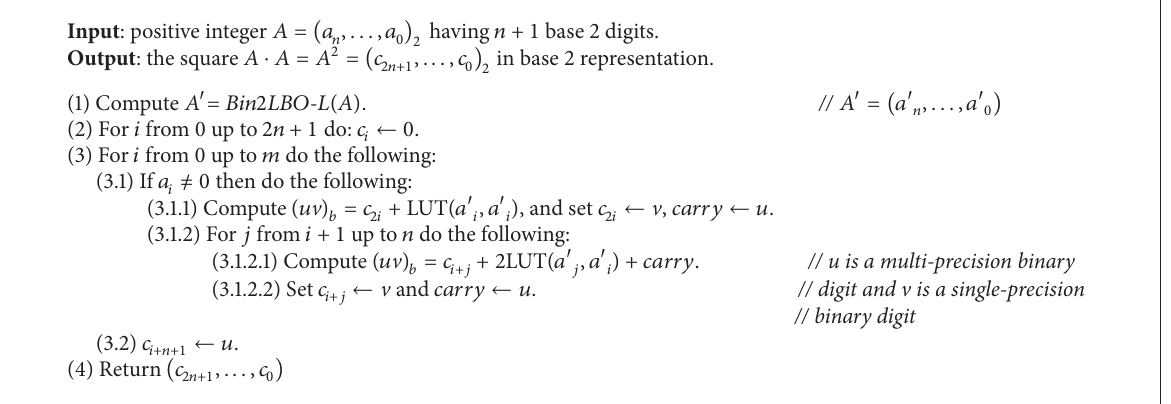
Algorithm 9: Multiple-precision classical squaring, BOSQ (𝐴)